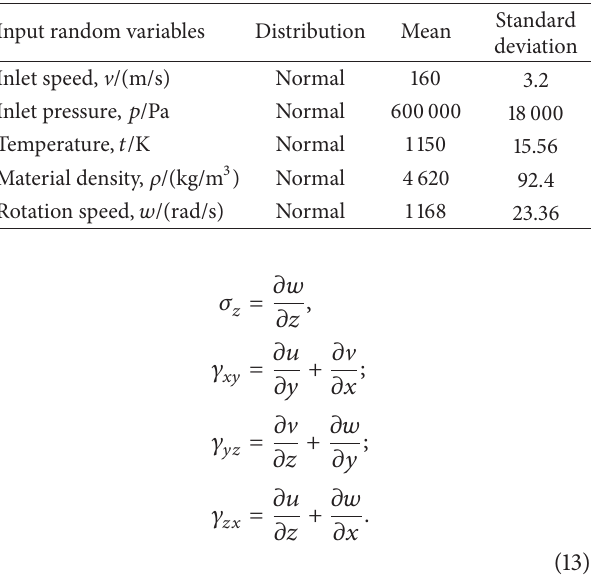
Table 1: Input random variables of MRSM reliability